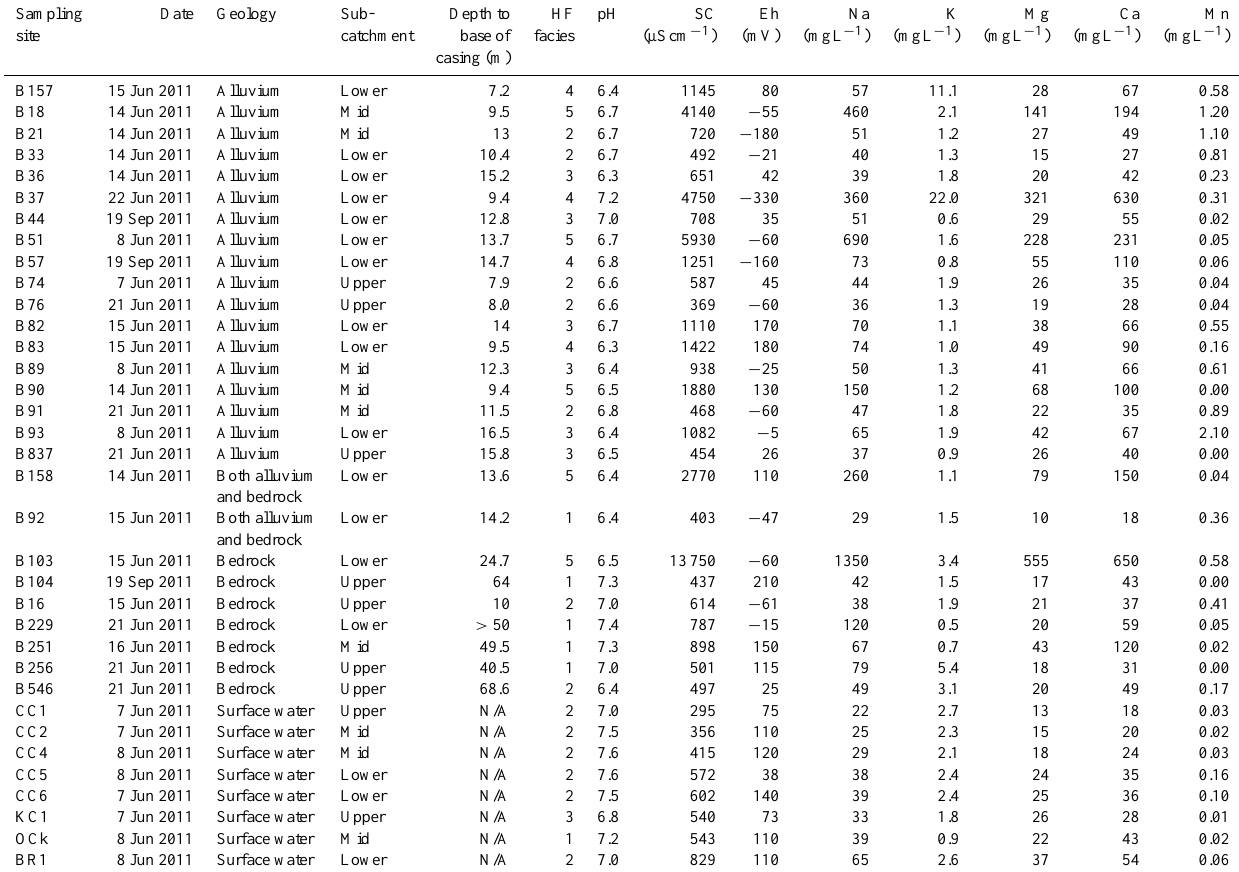
Table 3a. Hydrochemical data for surface and groundwater samples from Cressbrook Creek catchment.